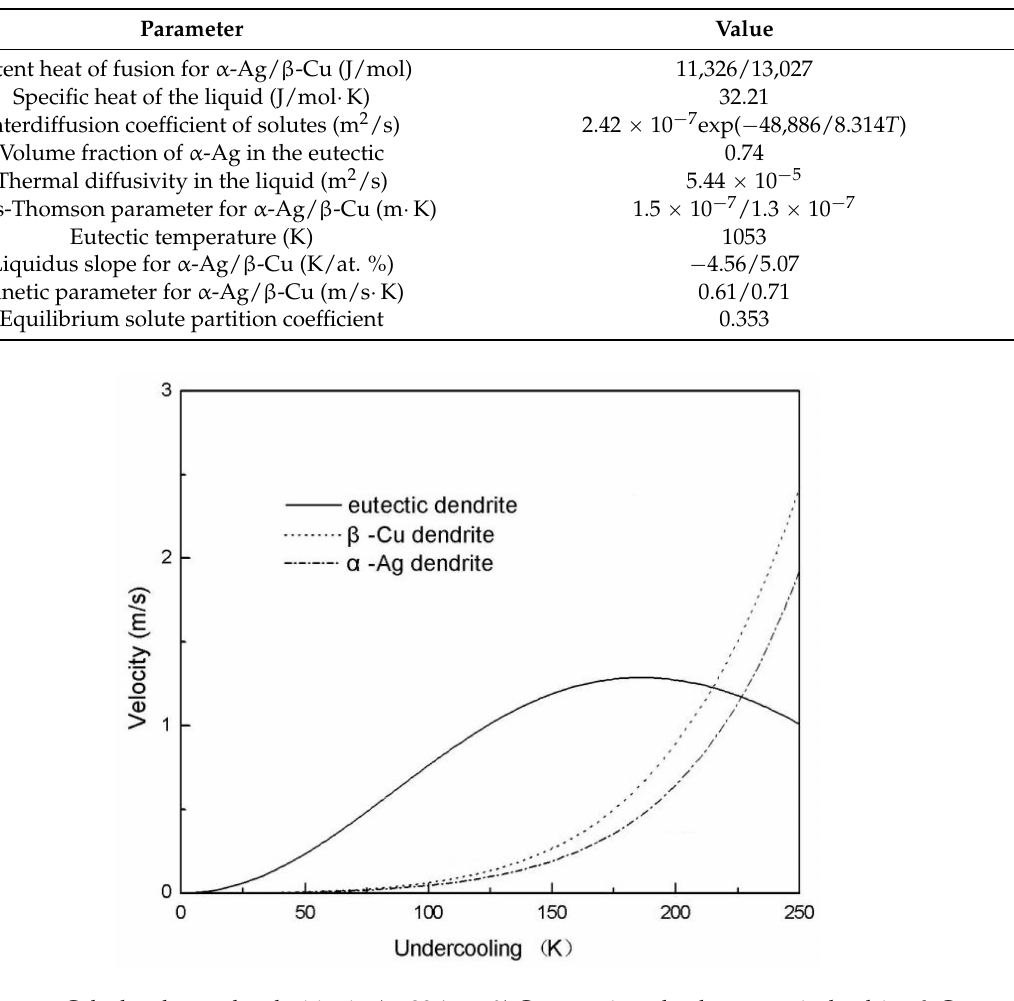
Figure 9. Calculated growth velocities in Ag-28.1 wt. % Cu eutectic melt when eutectic dendrite, β -Cu dendrite or α -Ag dendrite is assumed to